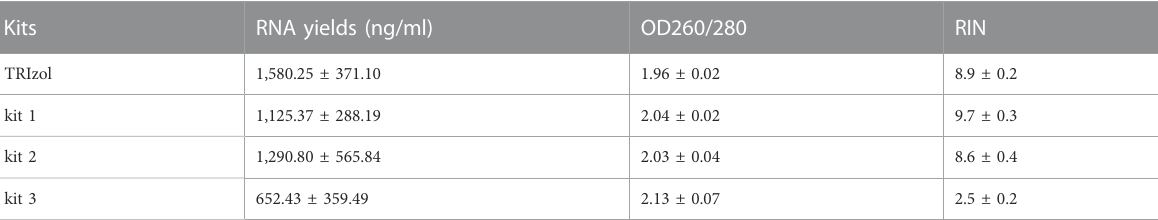
TABLE 1 The quality of PBL-derived RNA extracted by different kits varies widely a . Kits